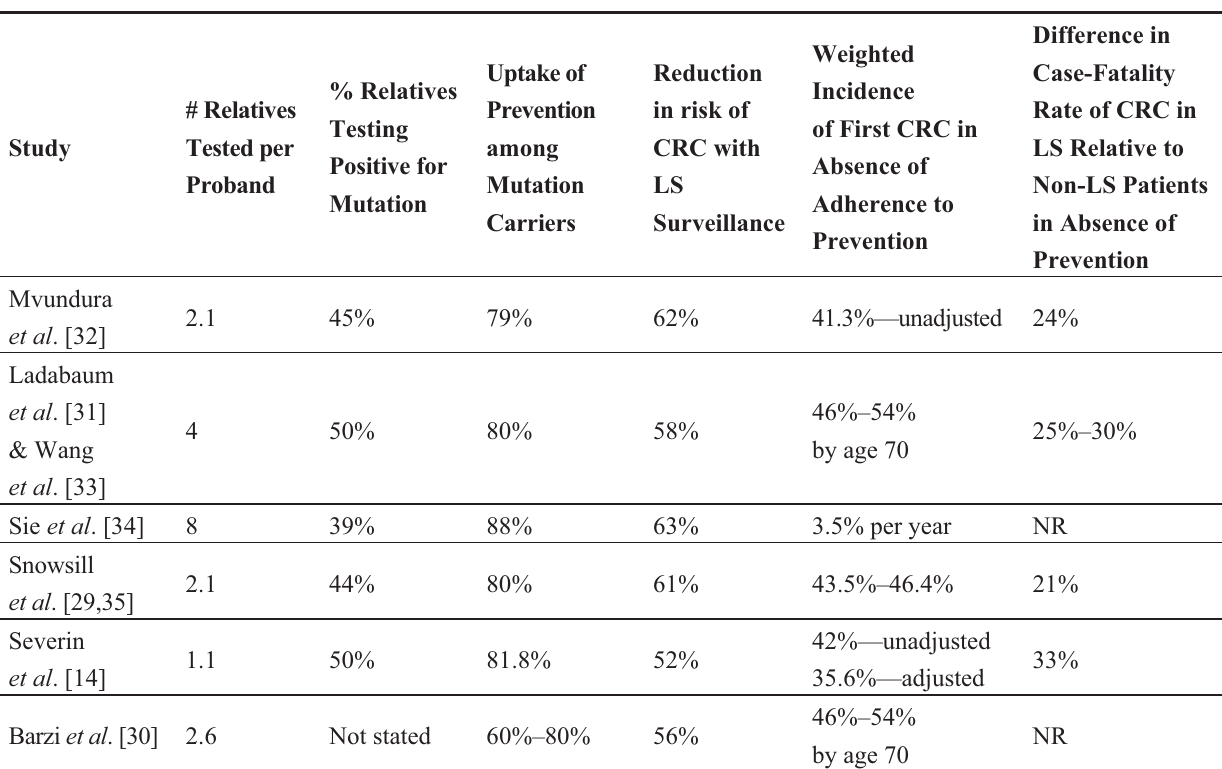
Table 5. Base case values of epidemiologic parameters in cost-effectiveness studies of routine testing for Lynch Syndrome (LS) in patients with colorectal cancer (CRC) that relate to asymptomatic mutation